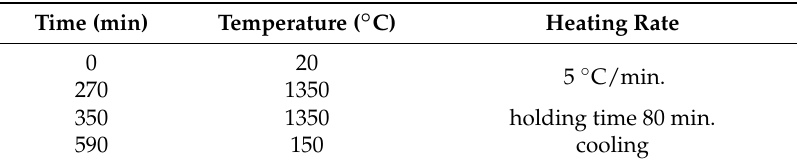
Table 9. A sintering cycle used for the